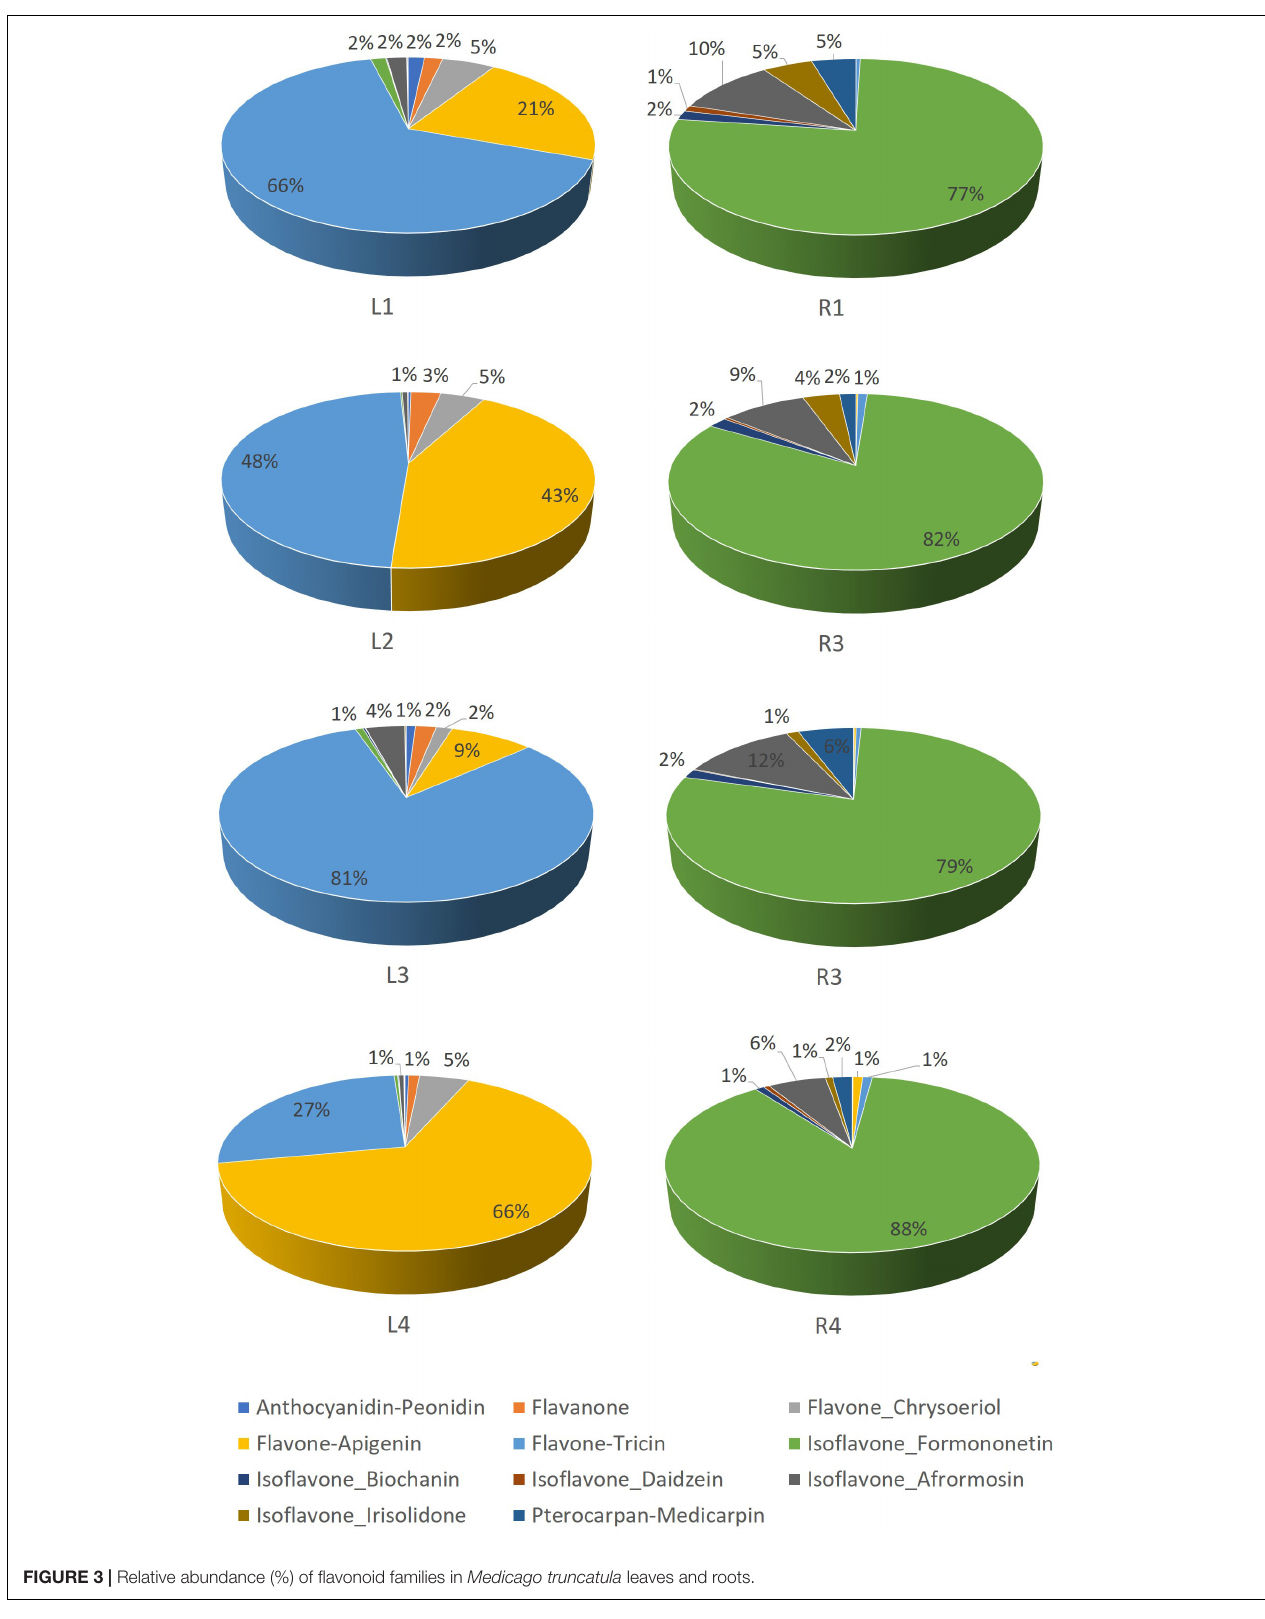
Frontiers in Plant Science |